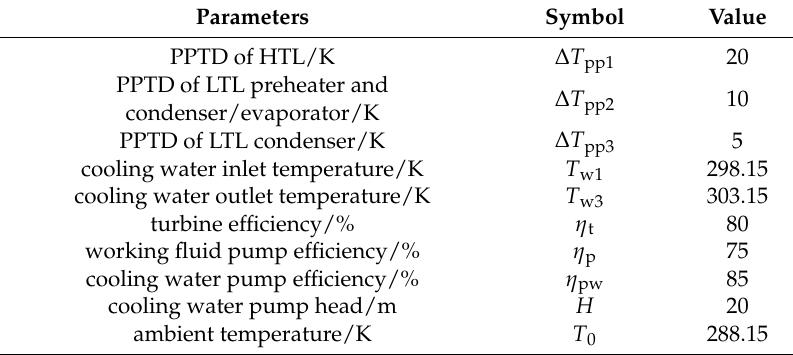
Table 6. DORC parameters.